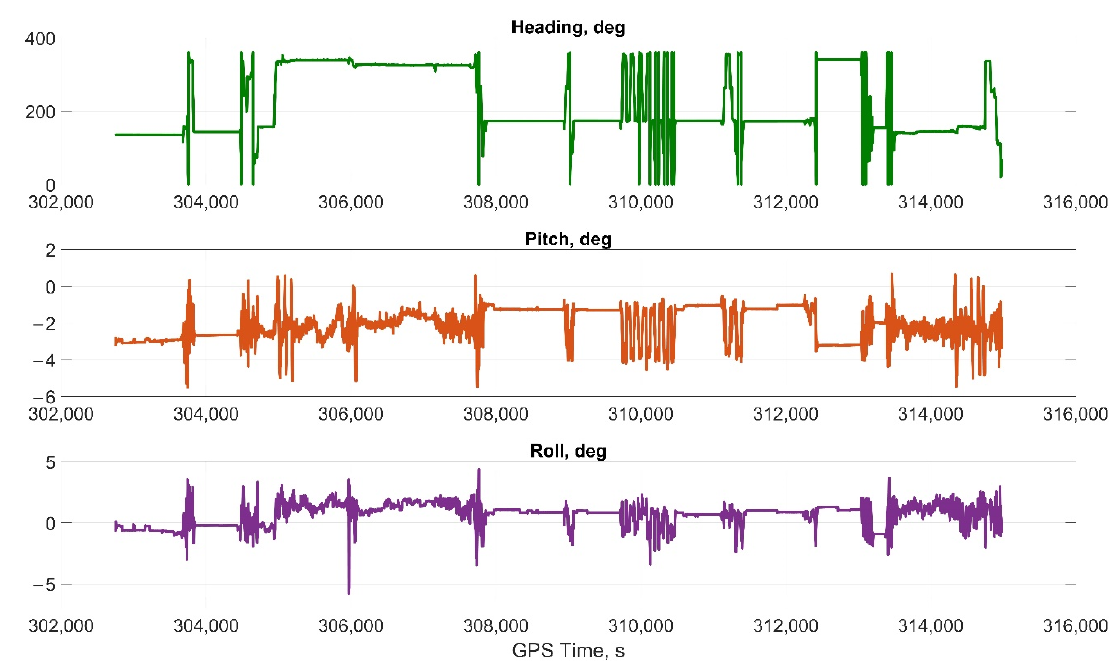
Figure 6. Reference values of the attitude angles in car test.